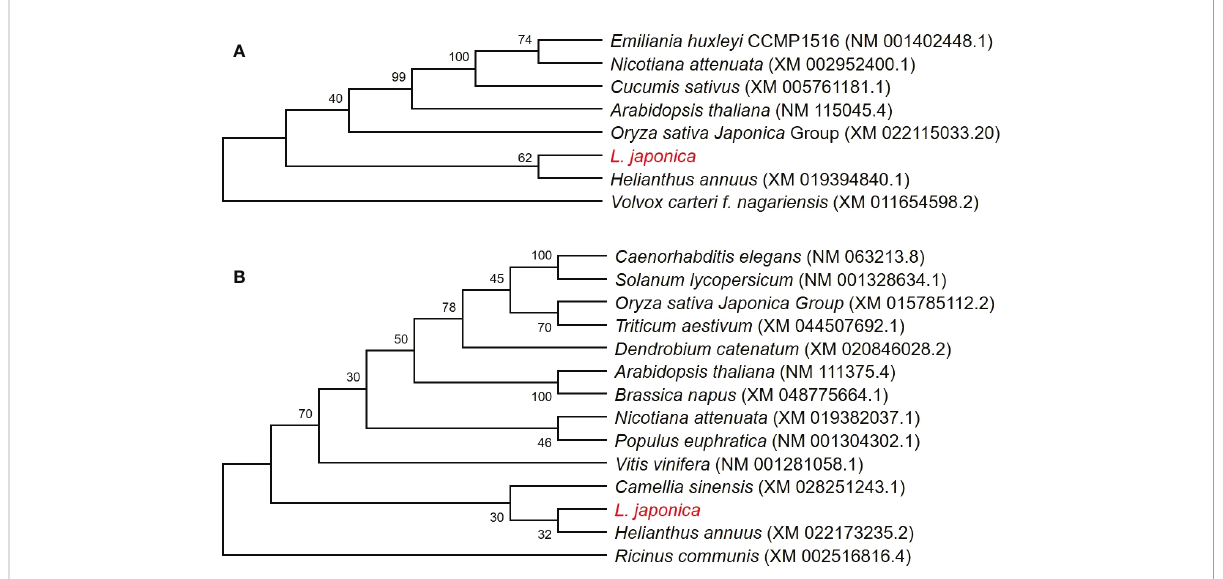
FIGURE 9 Phylogenetic analyses of CAX3 and NHX2 in L. japonica and other species. Phylogenetic trees were generated using CAX3 of L. japonica with other 7 species (A) , and NHX2 of L. japonica with other 13 species (B) , respectively. The numbers at nodes in the phylogenetic tree indicate bootstrap values per 1000 replicates. The coding sequences were obtained from NCBI and the source of data is noted after species